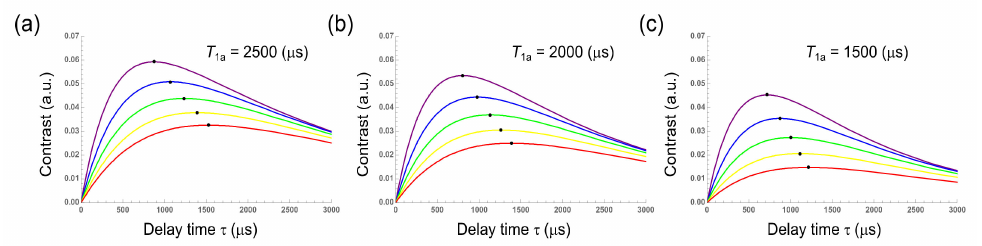
Figure 2. Simulation of T 1 change from T 1a (2500 ( a ), 2000 ( b ) and 1500 ( c ) ( µ s) to T 1b (1000 (red), 850 (yellow), 700 (green), 550 (blue) and 400 (purple)) which are typical values of 100-nm nanodiamonds. Graphs shows the contrasts of T1-weighted images between T 1a and T 1b using interval time τ . Black dots represent maximum points of the contrast. These points shift depending on both T 1a and T 1b .